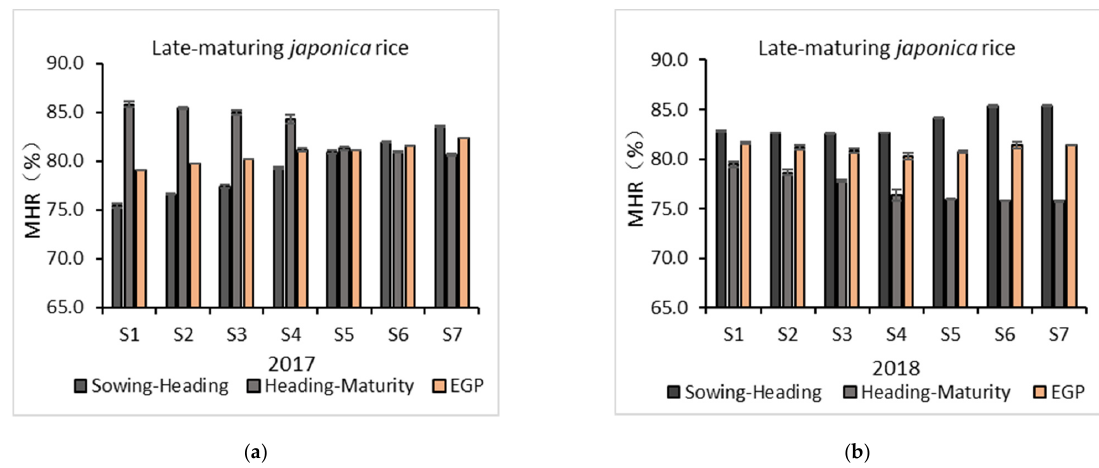
Figure 7. Difference of mean relative humidity (MRH) of late-maturing japonica rice under different sowing dates: ( a ) 2017; ( b ) 2018.